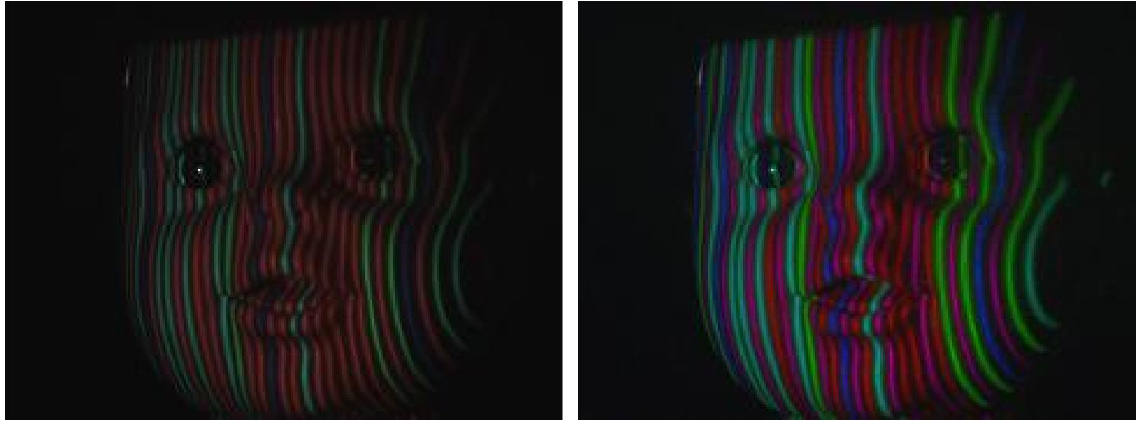
Figure 6. An example of adaptive albedo calibration. ( a ) face model under illumination patterns; ( b ) calibrated image of face model; ( c , d ) histograms of (a,b)